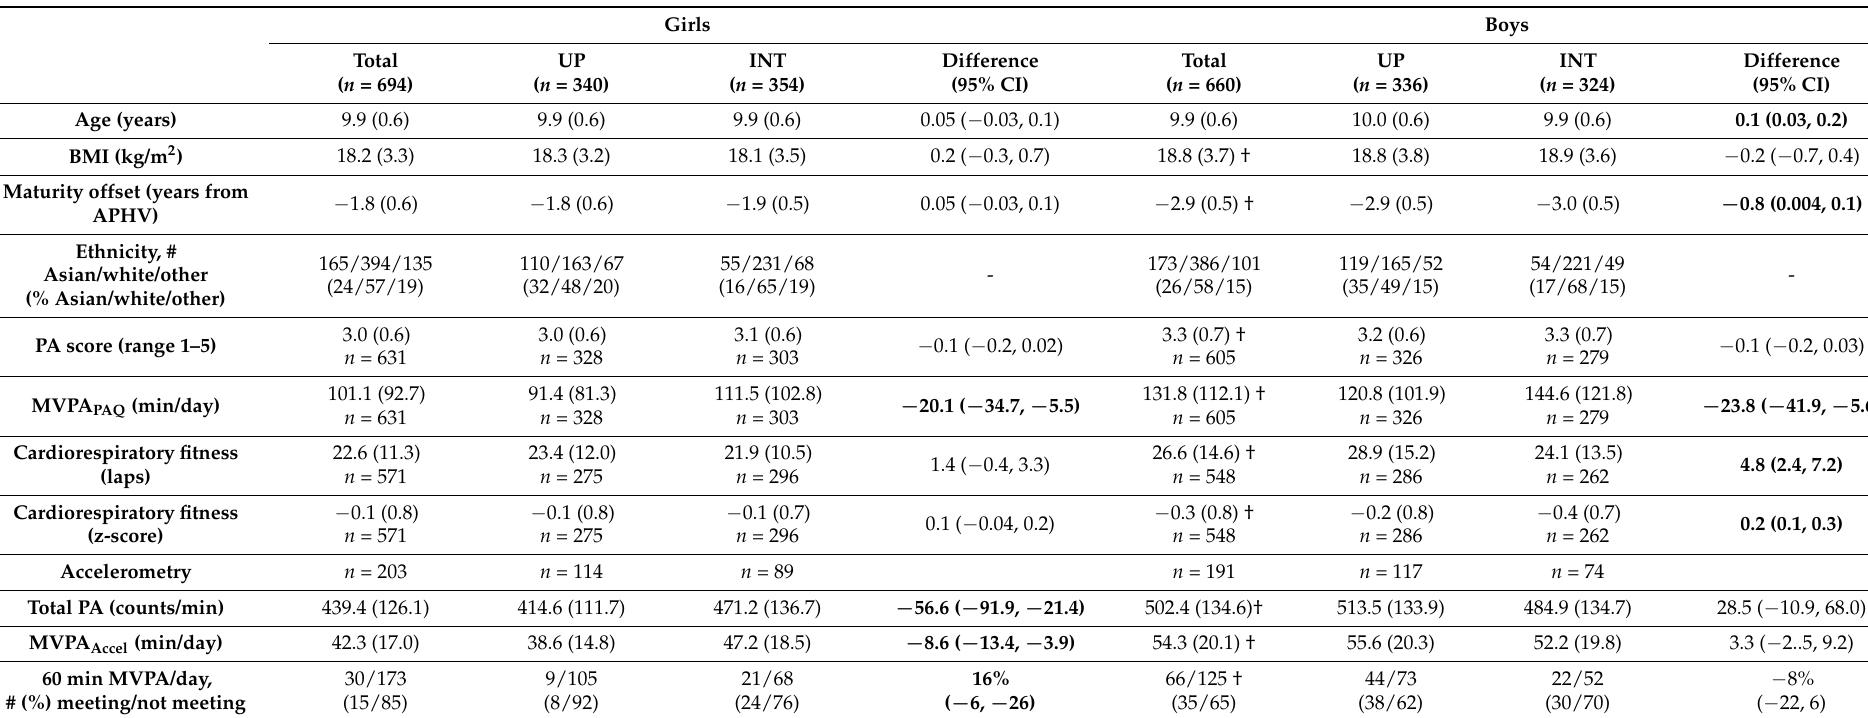
Table 3. Baseline values for girls and boys at usual practice (UP) and intervention (INT) schools. Only participants with complete data for the covariates age, BMI and ethnicity are included (see note). Values are mean (SD) or number